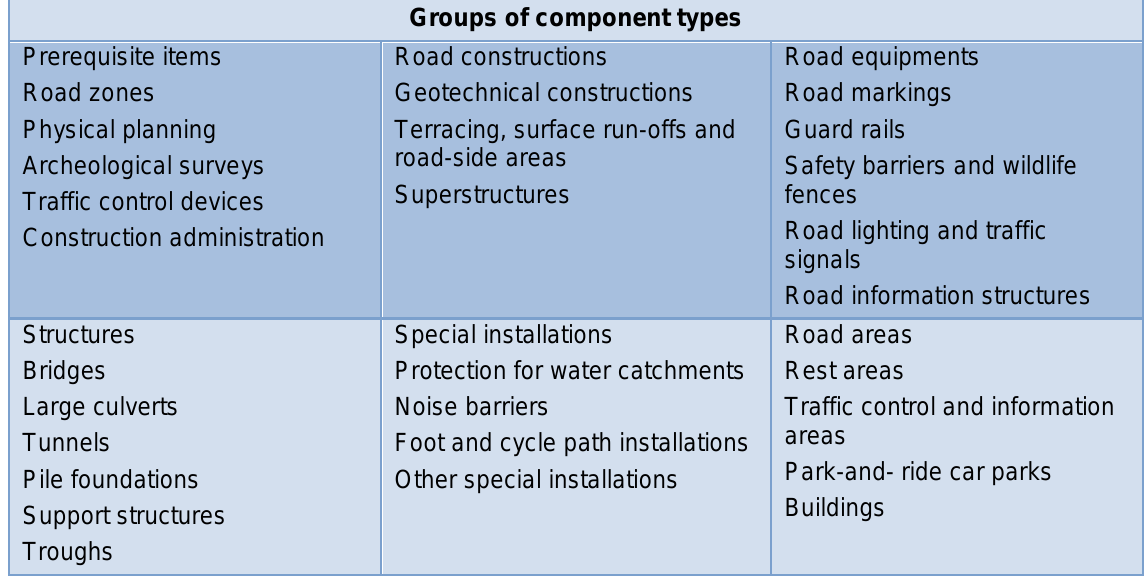
Table 2 Road components Source: Jonsson (2012)